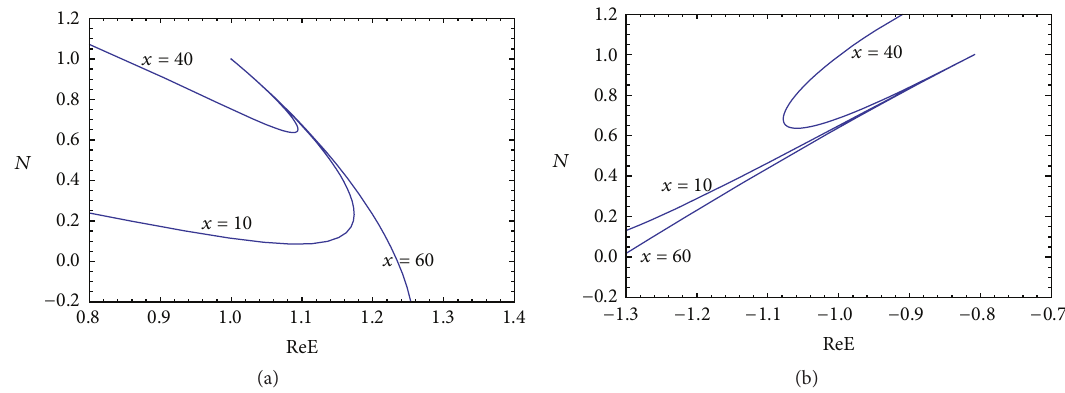
Figure 1: Hook heteroclinic orbits for Schr¨odinger-Boussinesq equation as 𝑡 → −∞ (a) and 𝑡 → +∞ (b).